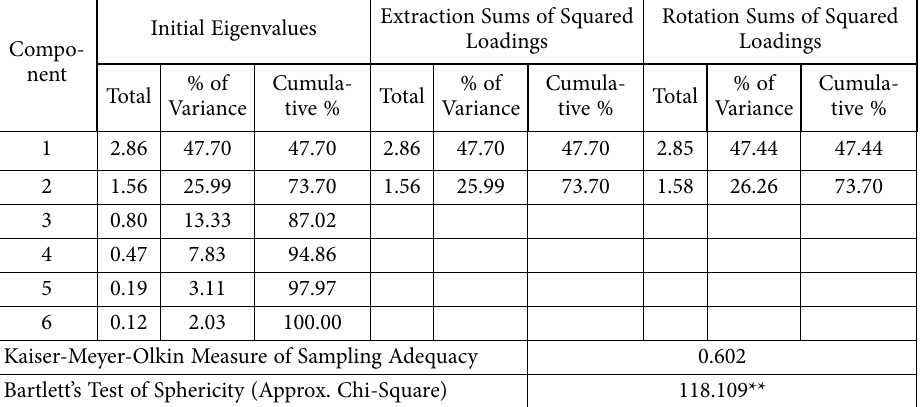
Extraction Sums of Squared Rotation Sums of Squared Loadings Loadings